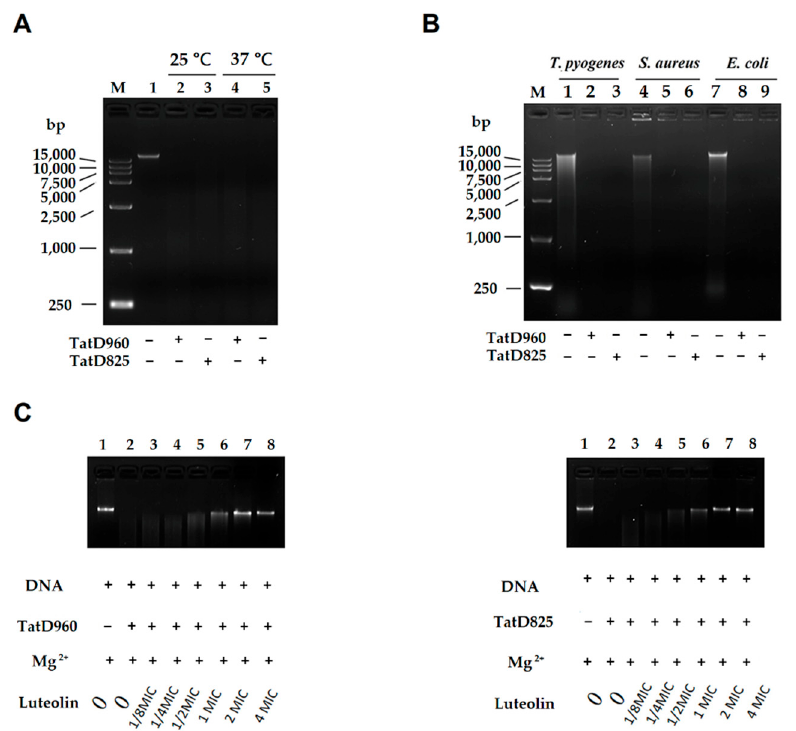
Figure 6. The inhibitory effect of luteolin on the hydrolysis of DNA by TatD DNases. ( A ) TatD DNases could degrade DNA extracted from mice at 25 °C and 37 °C, ( B ) TatD DNases were able to hydrolyze DNA extracted from bacteria, ( C ) luteolin can inhibit the hydrolysis of DNA extracted from mice by TatD DNases and showed concentration dependence. M: DNA Marker; 1–9: Sample with different treatment.